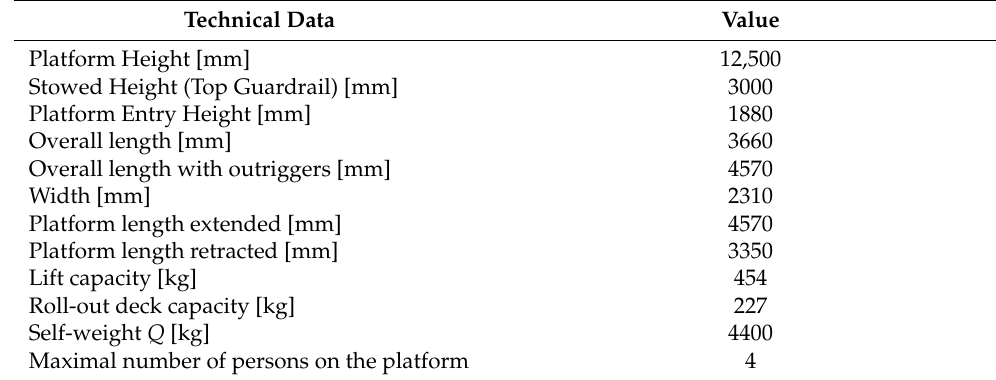
Table 1. Selected technical data and geometrical dimensions of the scissor lift MEC 4191RT [52]. Technical